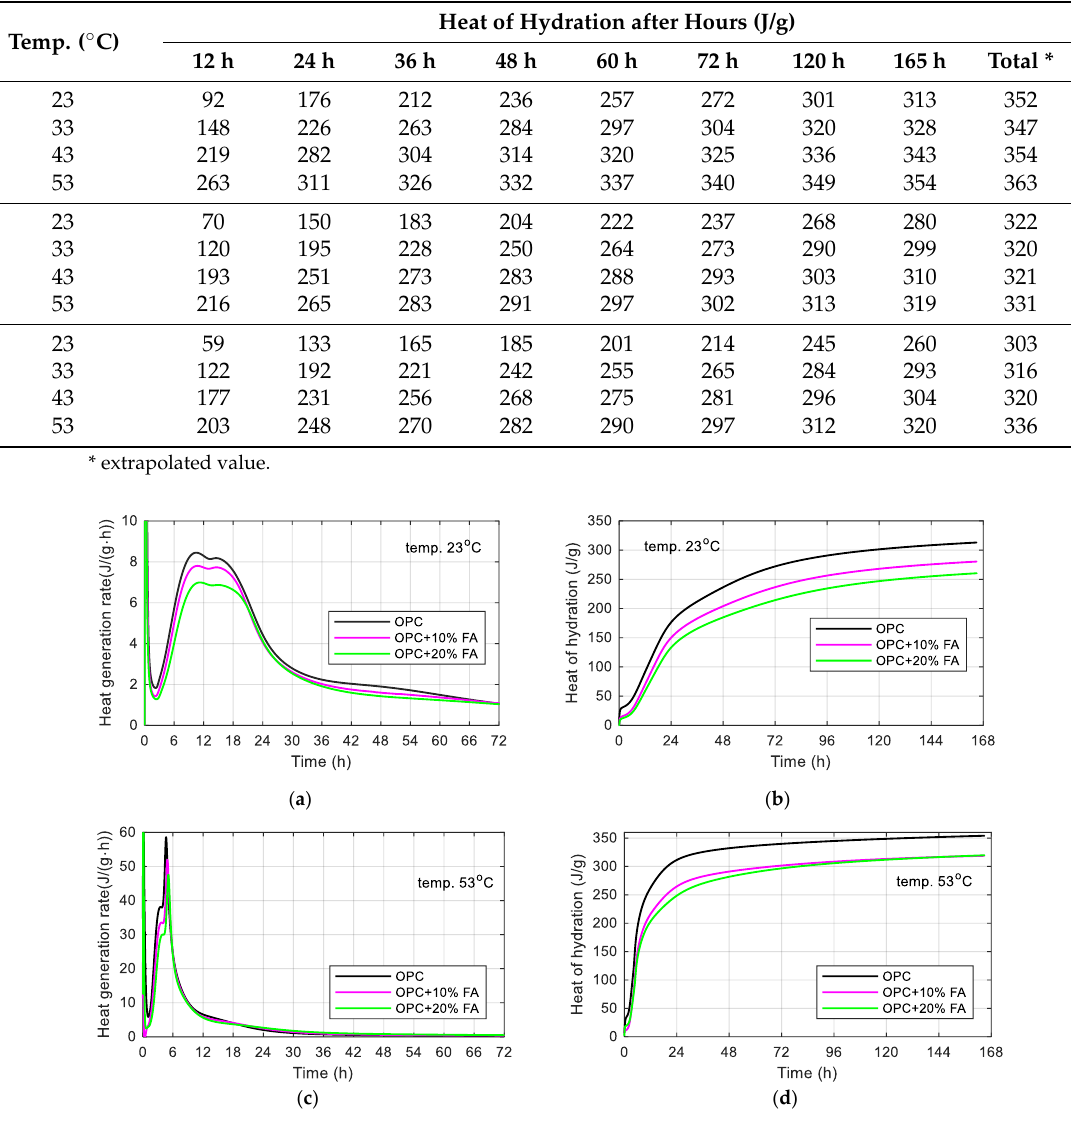
Figure 2. Results of calorimetric tests for OPC mortar mixtures: ( a ) the heat generation rate at first 72 h, ( b ) heat of hydration during 165 h.